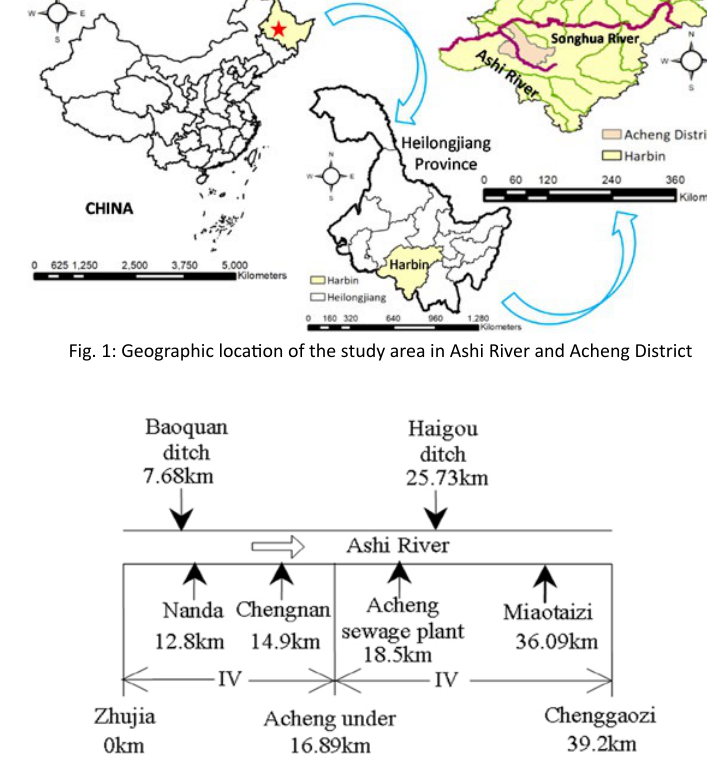
Fig. 2: Discharging system of the study area (Zhujia-Chenggaozi River Reach)